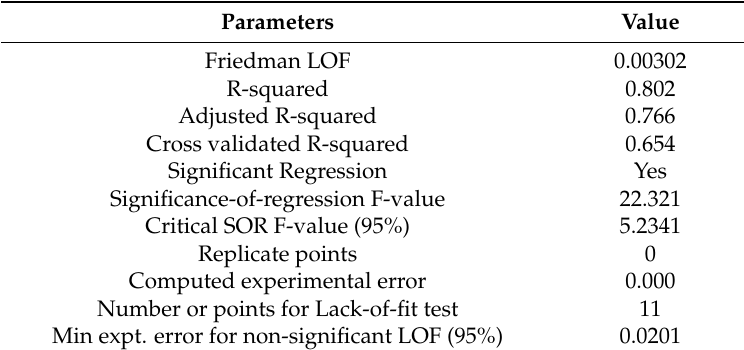
Table 4. Validation of the genetic function